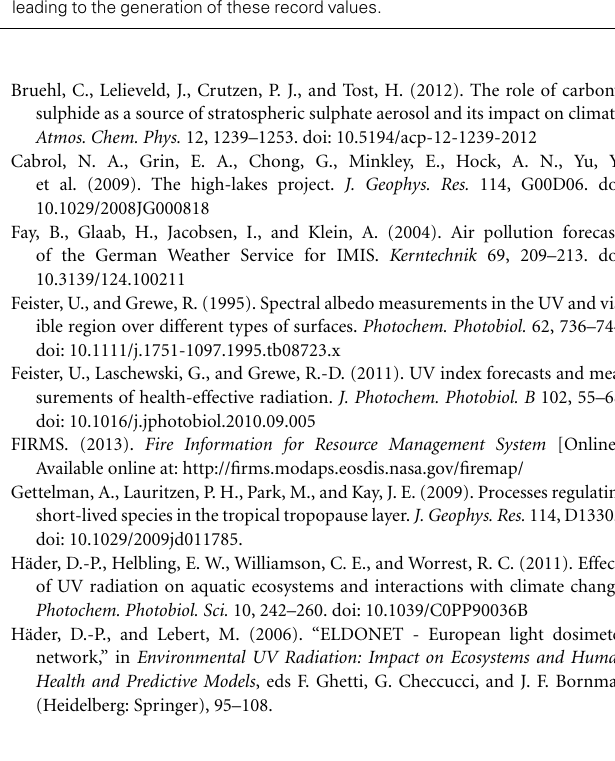
FIGURE 5 | Comparison of UV-B profiles at both sites. Located 10km apart, thetwodosimetersrecordedconsistentdata.DifferenceinUV-Bamplitudeare explained by elevation differences, and by local weather at the summit of Licancabur. (A) Before, between, and after major UV-B spikes, both instruments showed normal UV profiles; (B) The December 29, 2003 event wasunique toLicancabur. CloudfractionandUVprofileatLaguna Blancashow